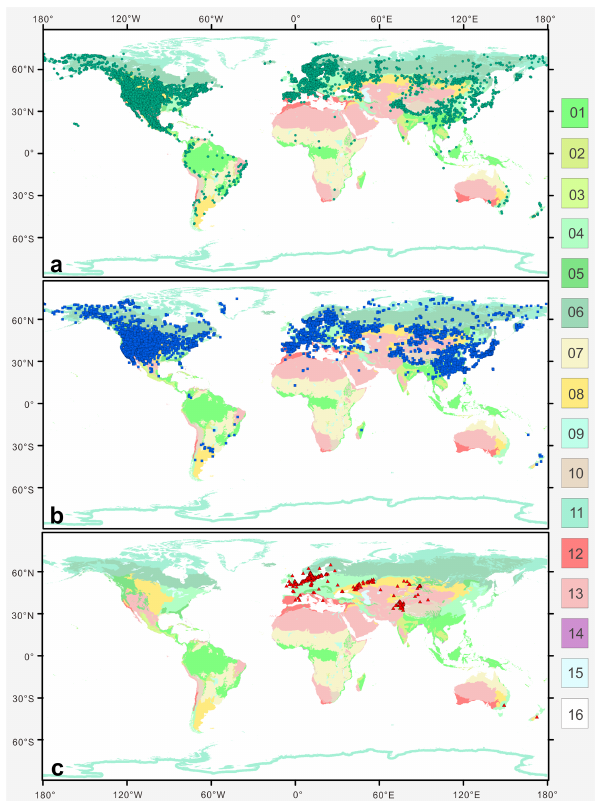
Figure 21. The global distribution pattern of three Artemisia pollen types in terrestrial biomes (modified from Olson et al., 2001). (a) SG type; (b) LNS type; and (c) SWS type. Fourteen terrestrial biomes: 01. tropical and subtropical moist broadleaf forests; 02. tropical and subtropical dry broadleaf forests; 03. tropical and subtropical coniferous forests; 04. temperate broadleaf and mixed forests; 05. temperate coniferous forests; 06. boreal forests/taiga; 07. flooded grasslands and savannas; 08. montane grasslands and shrublands; 09. tundra; 10: Mediterranean forests, woodlands, and shrub; 11. tropical and subtropical grasslands, savannas, and shrublands; 12. temperate grasslands, savannas, and shrublands; 13. deserts and xeric shrublands; 14. mangroves; 15. lakes; 16. rock and ice.